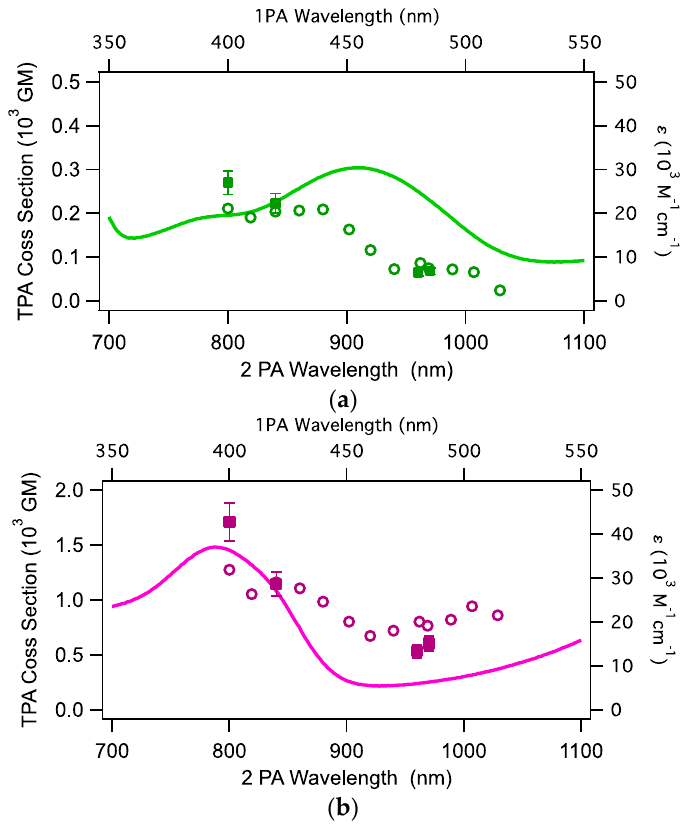
Figure 6. One-photon (plain line) and two-photon absorption spectra of ( a ) Ru-1 and ( b ) Ru-2 in dichloromethane. The open circles are the values obtained with the WL-scan procedure and filled squares with error bars are those with the power-scan procedure (see text). For the data at 860 nm or shorter, saturable absorption (SA) of OPA was significantly observed and the analysis considering SA was employed for Ru-2 .